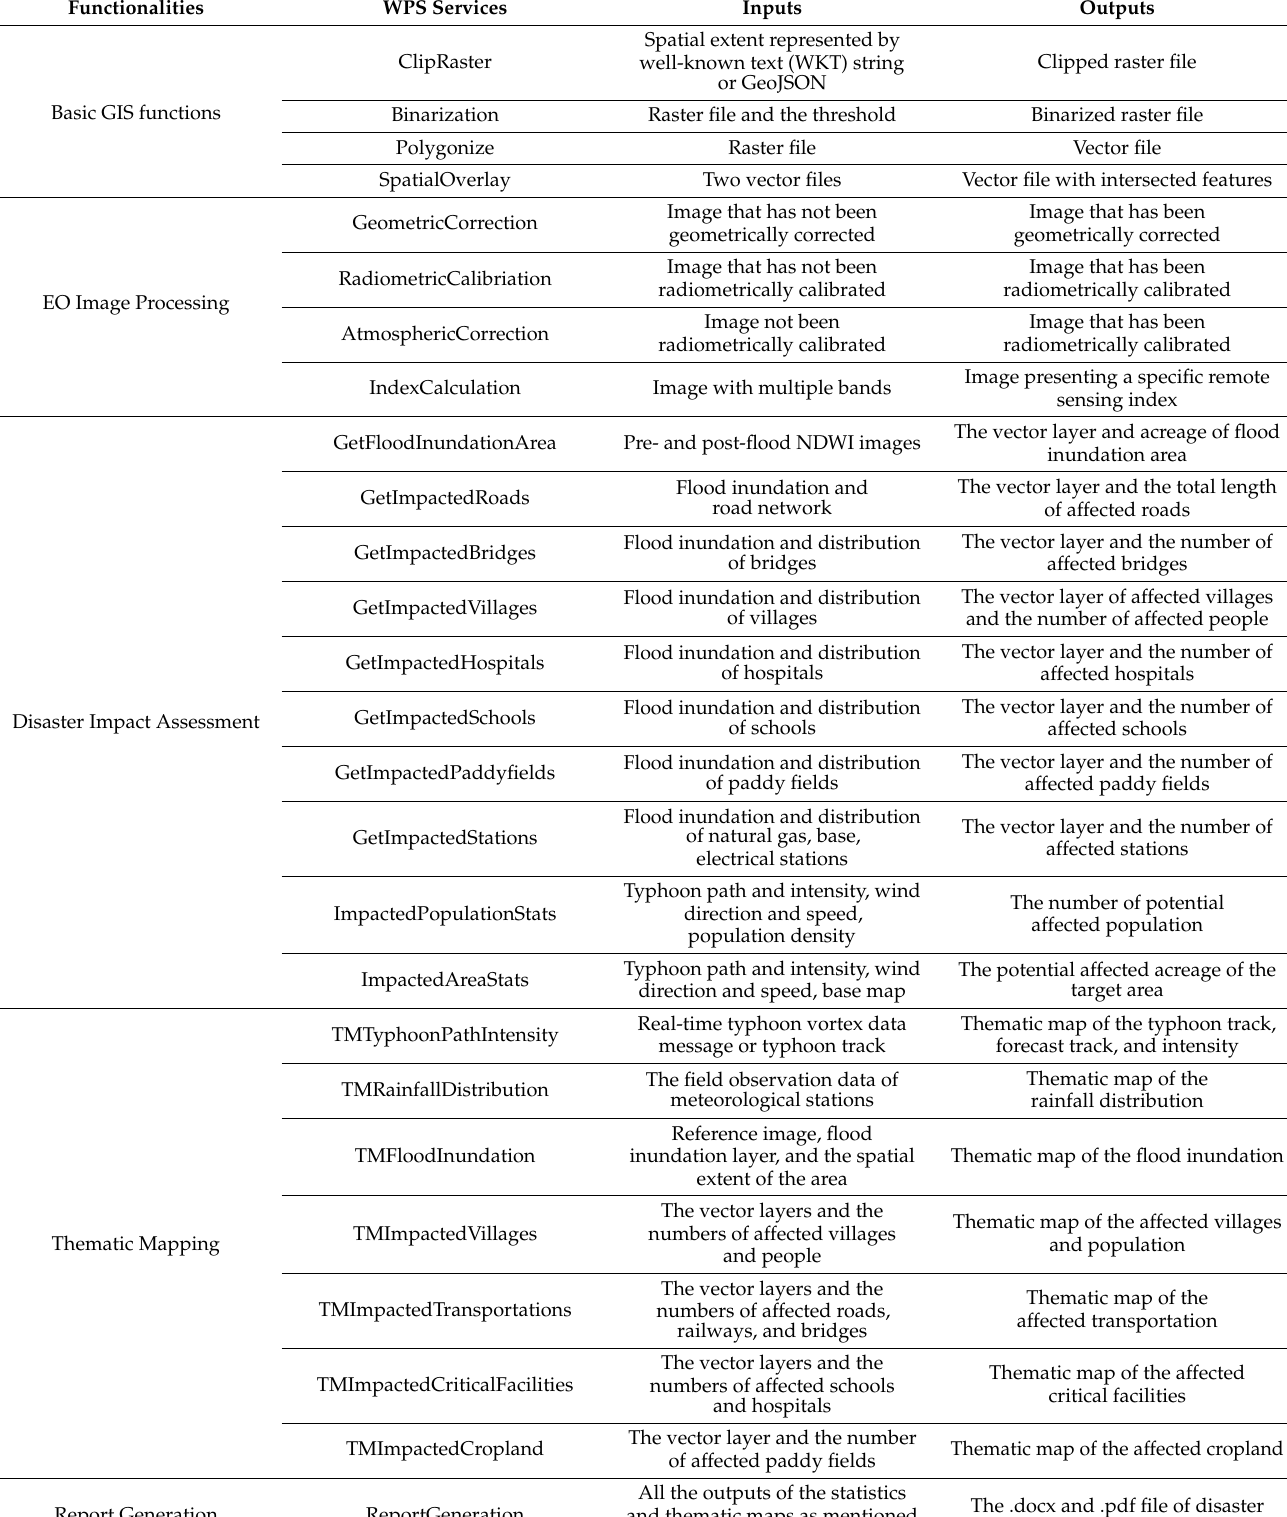
Table 4. WPS services implemented in RDDSS